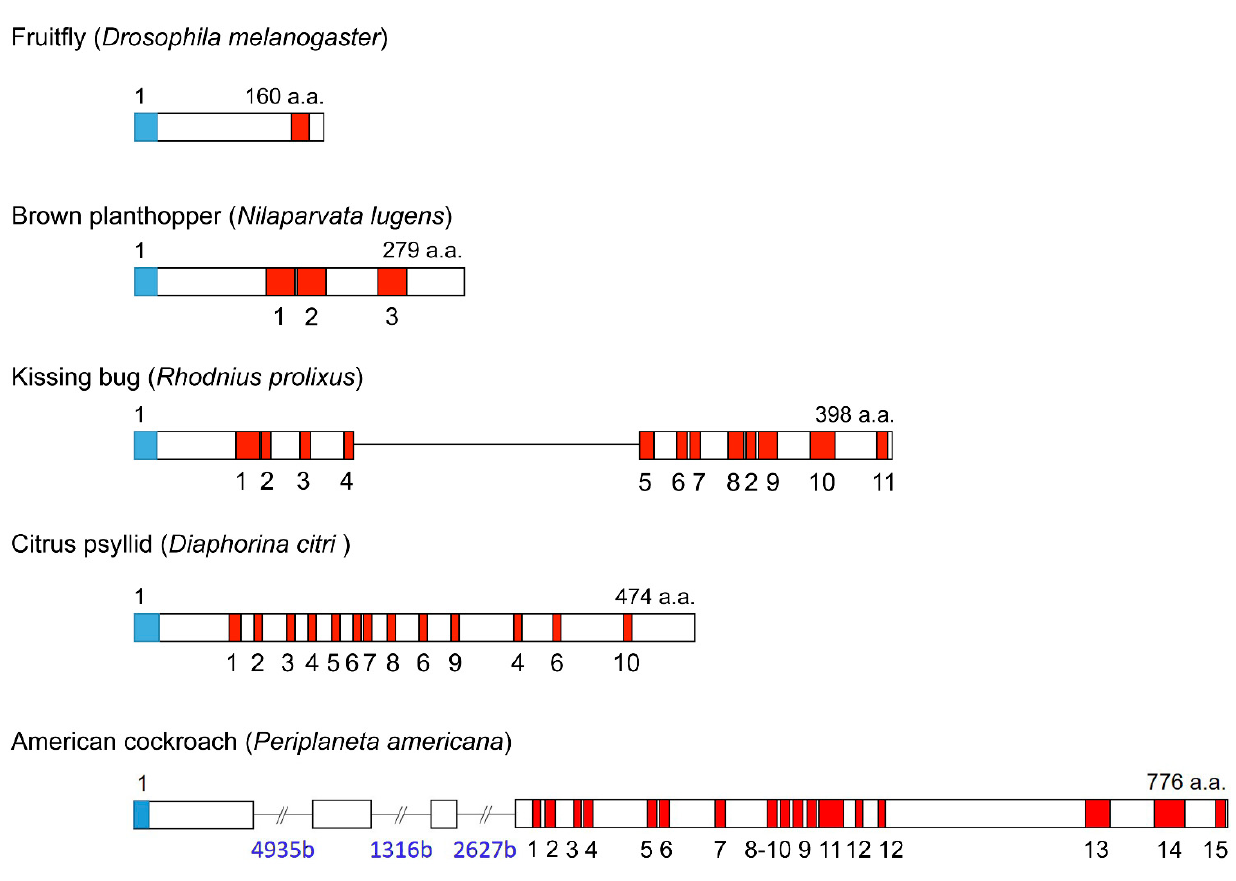
Figure 2. Schemes of organization of representative arthropod leucokinin precursors. Boxes and lines show exons and introns, respectively. Red boxes represent leucokinins, and signal peptides are indicated by blue boxes. The lengths are given in amino acids (a.a.). Primary sequence data of fruit fly, brown planthopper, kissing bug, citrus psyllid, and cockroach were from Terhzaz et al. (1999) [17], Tanaka et al. (2014) [54], Te Brugge et al. (2011) [52], Li et al. (2020) [55], and Zeng et al. 2020 [20], respectively.